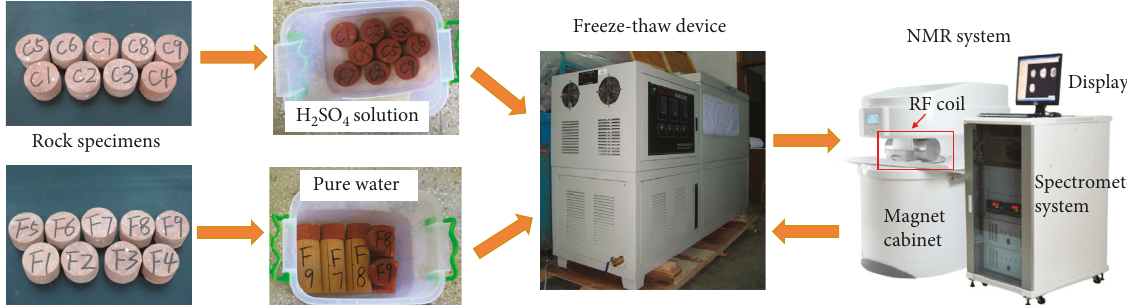
Figure 1: Sequence showing experimental setup and test procedure requiring rock specimen preparation, the TDS-300 freeze-thaw testing machine, and the AniMR-150 MRI analyzing